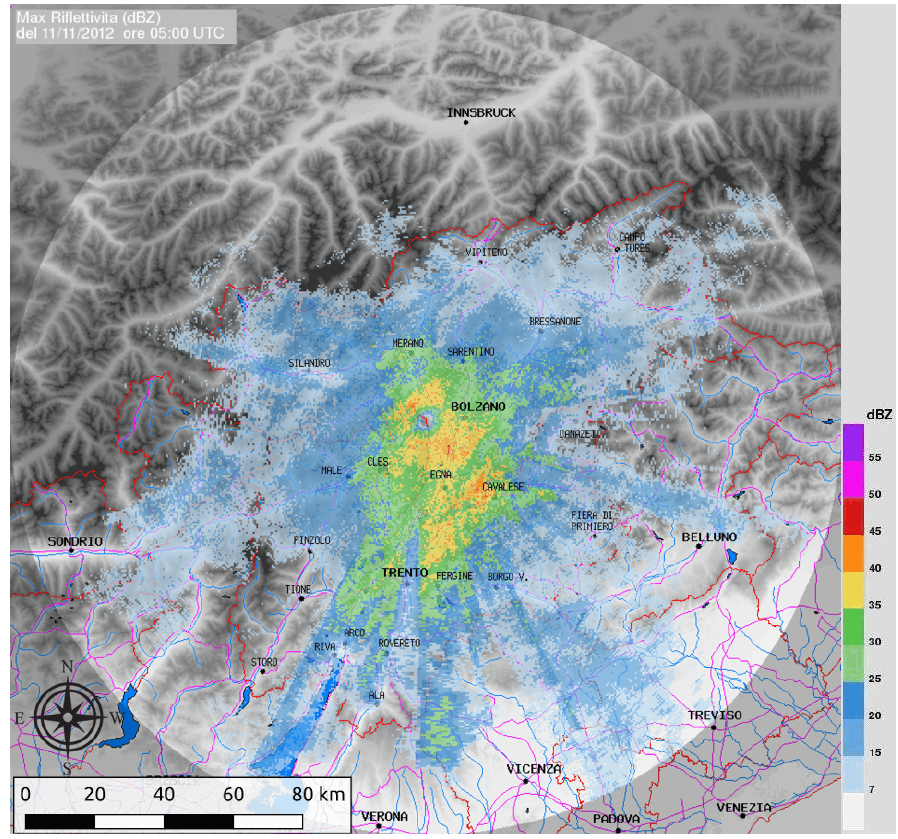
Figure 1. An example of observed radar reflectivity scan (MAX(Z) product) available in the TAASRAD19 dataset, represented in color scale over the geographical boundaries of the area covered by the radar. The area outside the observable radar radius is